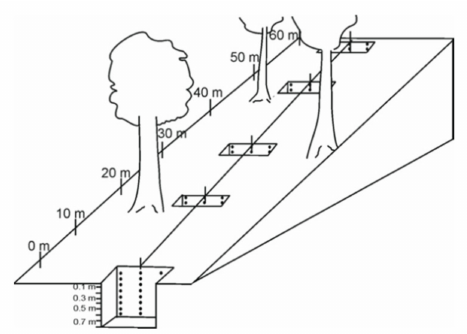
Figure 2. Soil sampling scheme along a 60-m long